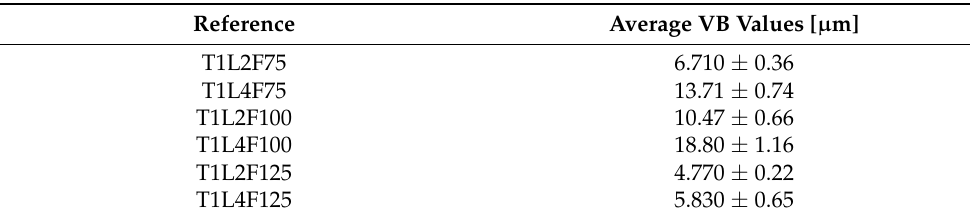
Table 7. Average VB values, obtained from measurements performed in the clearance faces of T1